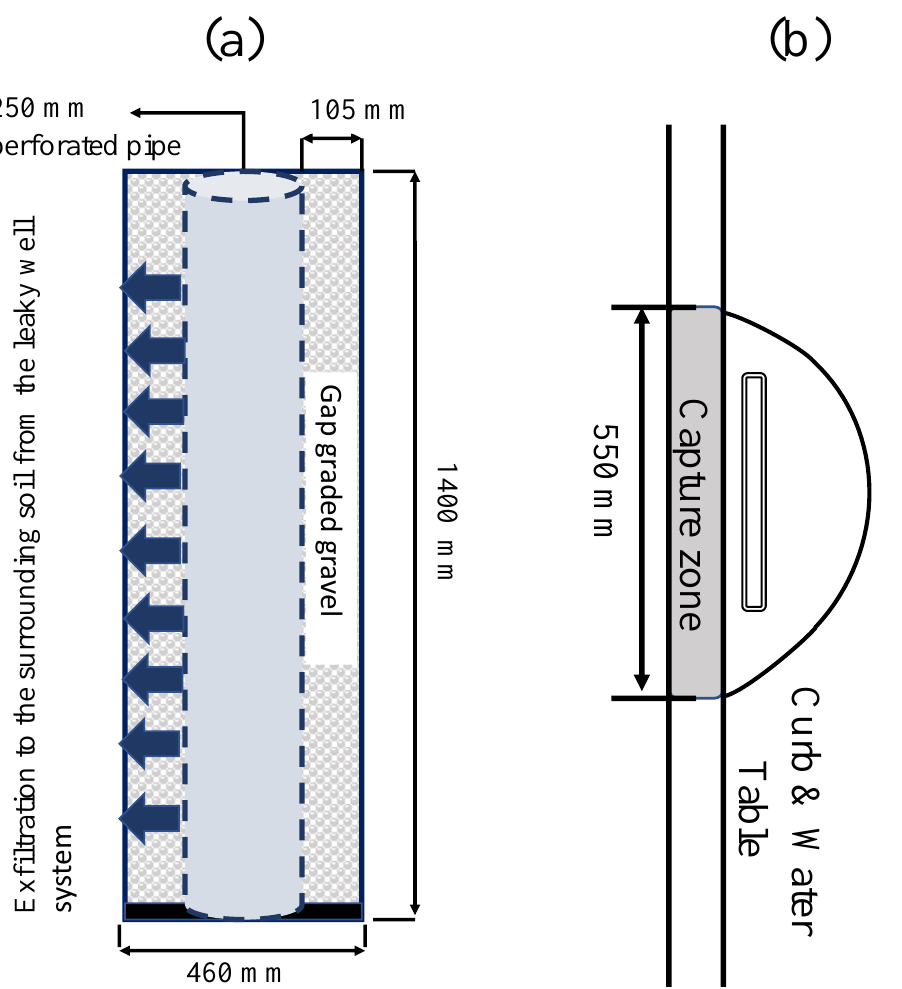
Figure 3. The layout of curbside leaky well systems. ( a ) The cross section of installed leaky well systems. The dimensions of the leaky wells are shown along with description of materials used ( b ). The face plate of R750 Treenet inlet is shown with capture zone.